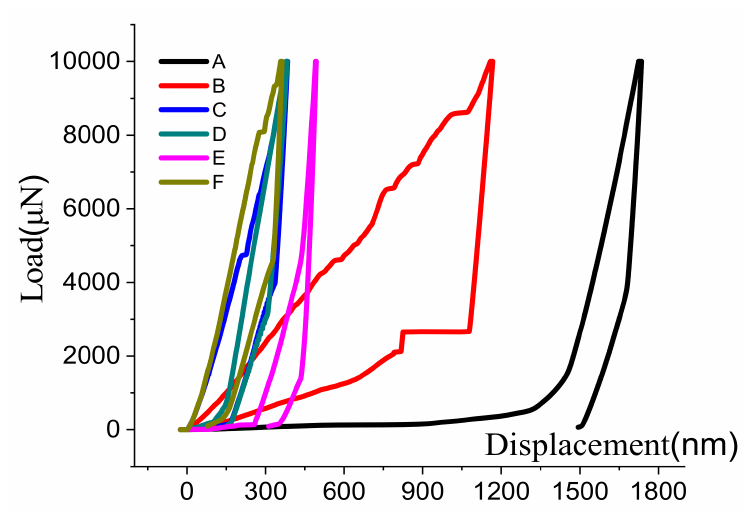
Figure 18. Load–displacement curves in black areas.